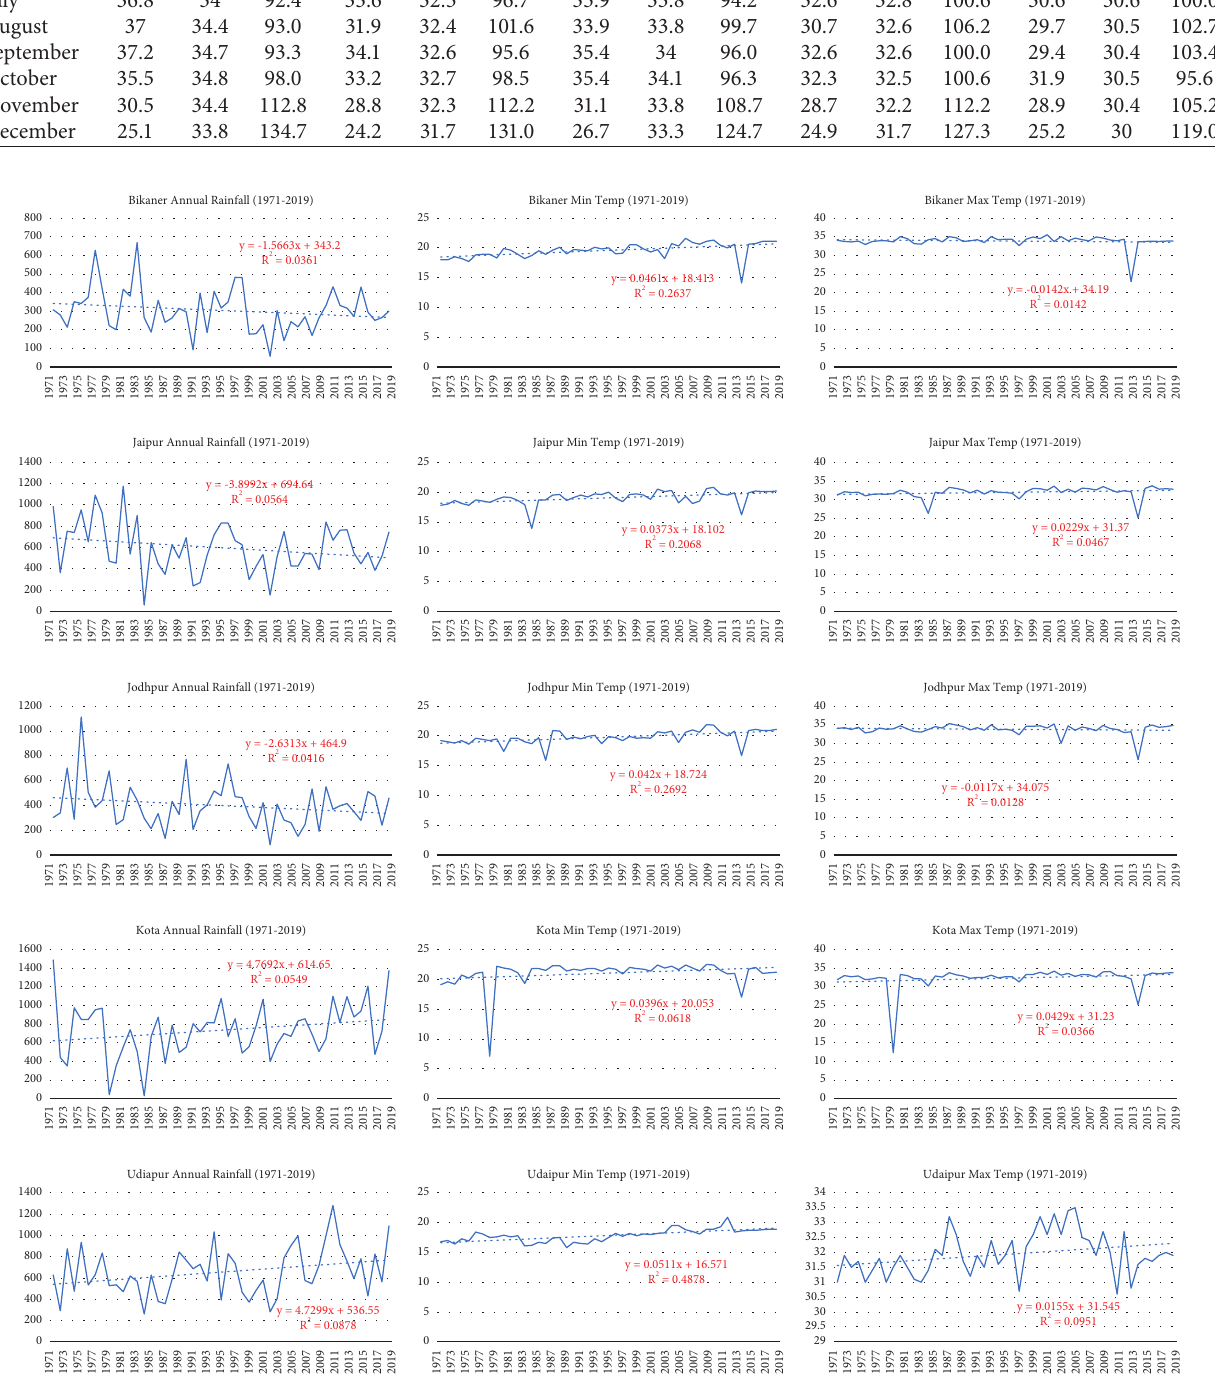
Figure 2: Annual trends of rainfall, min, and max temperature from 1971 to